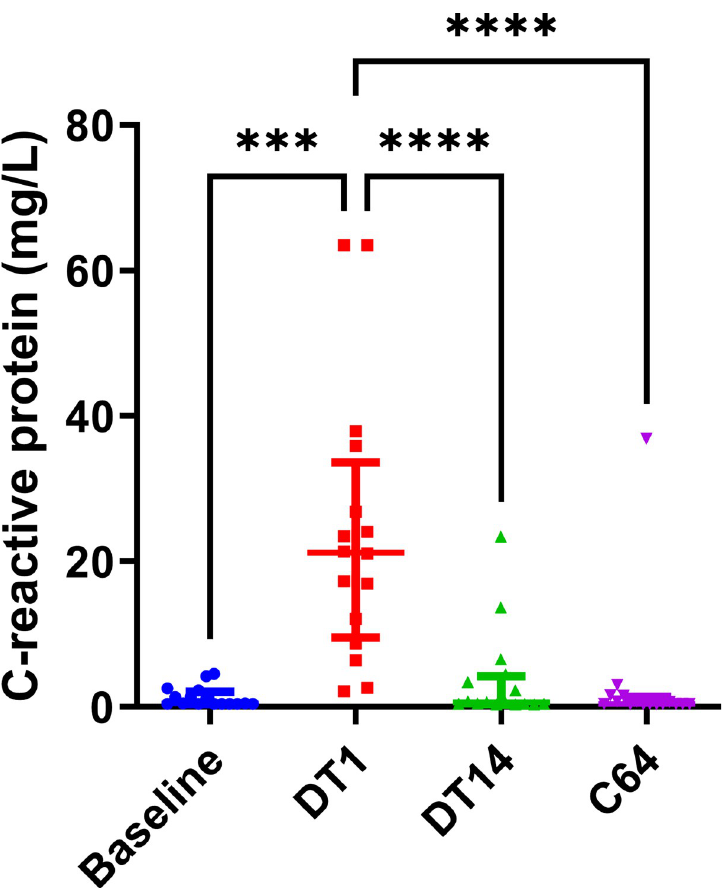
Fig 7. C-reactive protein levels in the four stages of plasmodium falciparum infection. Results are shown as the median and interquartile range, and ��� and ���� indicate a p-value below 0.001 and 0.0001, respectively.